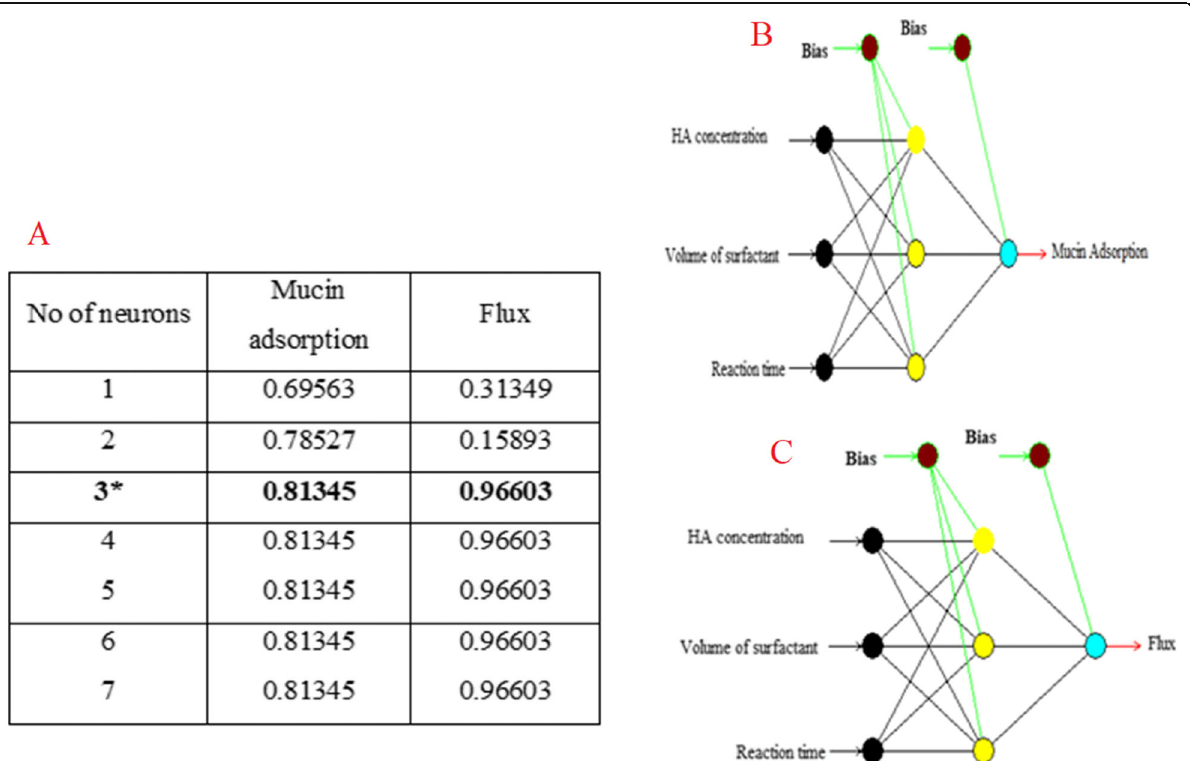
Fig. 1 a Determination of optimum number of neurons. b Architecture of the optimal ANN for predicting mucin adsorption. c Architecture of the optimal ANN for predicting